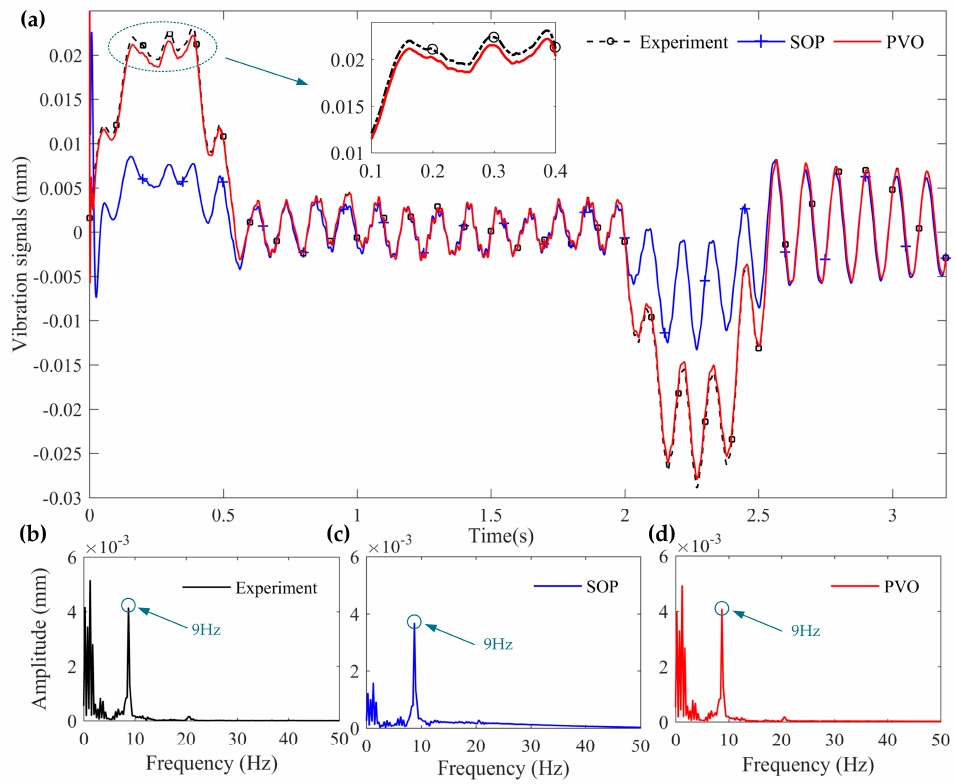
Figure 9. Tracking effect of the vibration signals ( x = 150 mm): ( a ) tracking effect in time domain; ( b ) amplitude spectra of the experiment results; ( c ) amplitude spectra of the SOP; and ( d ) amplitude spectra of the PVO.